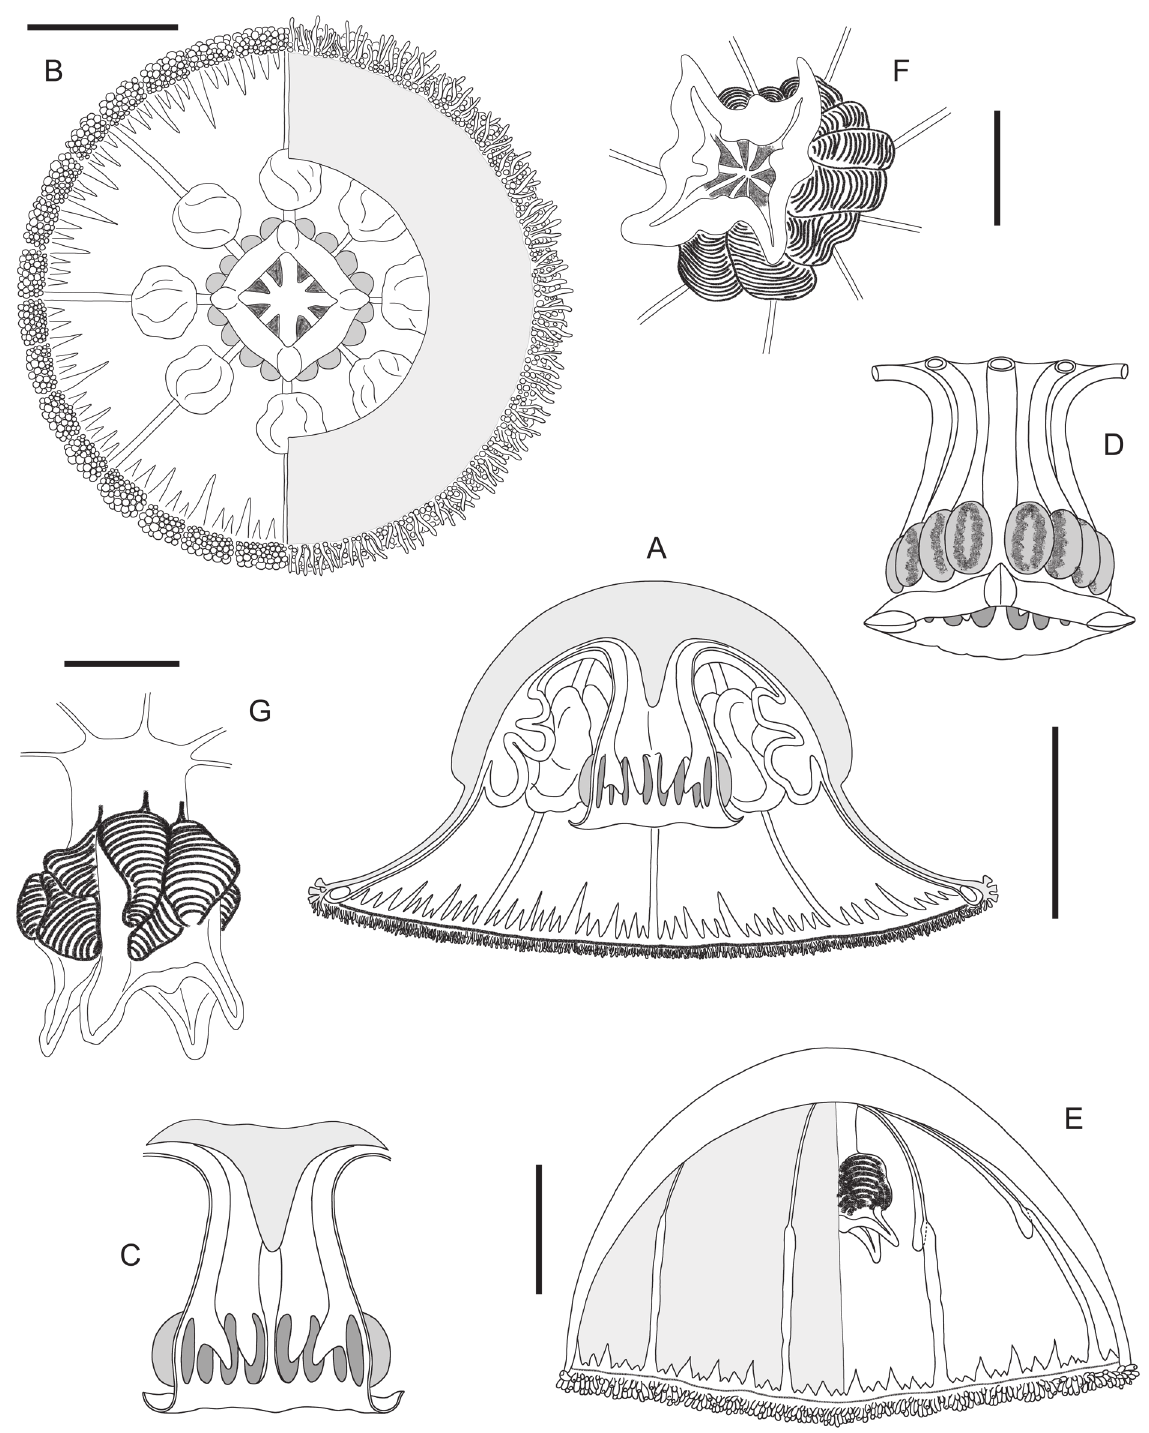
Fig. 5. — Pectis antarctica Haeckel, 1879. A – B . Medusa in lateral (A) and oral (B) views. C . Longitudinal section through the manubrium. D . Lateral view of the manubrium showing the outer, gastric pouches. E . Lateral view of Voragonema laciniata Bouillon et al ., 2001. F – G . Manubrium of V. laciniata in oral (F) and lateral (G) views. [A–D redrawn after Haeckel (1881b); E–G redrawn after Bouillon et al . (2001)]. Scale bars: A, B, E = 1 cm; F, G = 5